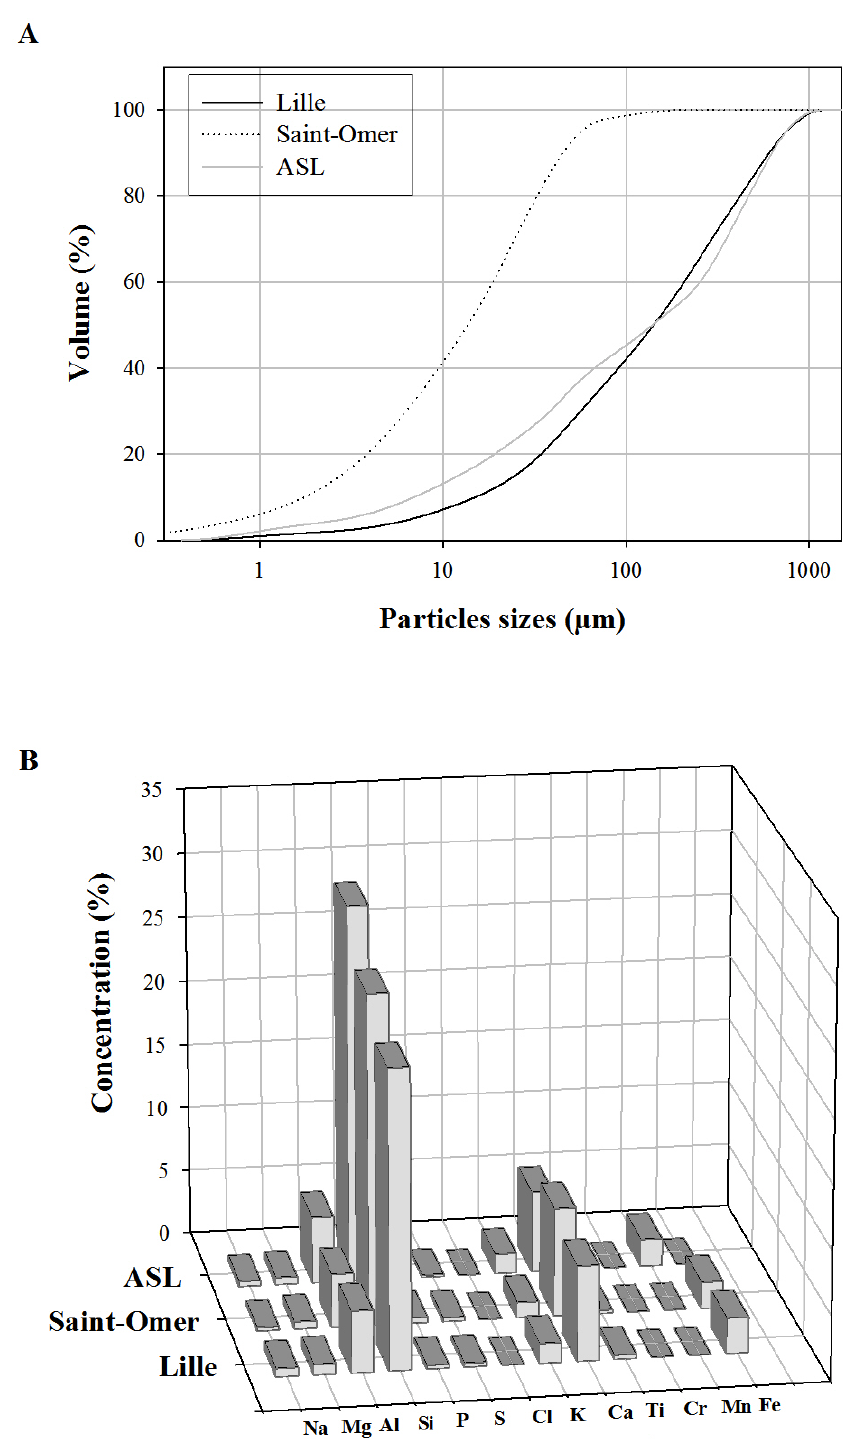
Figure 1. ( A ) Particle size distribution within the experimented sediments; ( B ) chemical composition of the three sediments .